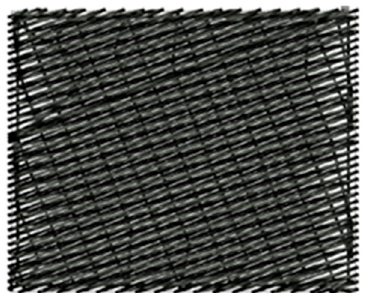
Figure 4. Object with a weave stitch line.